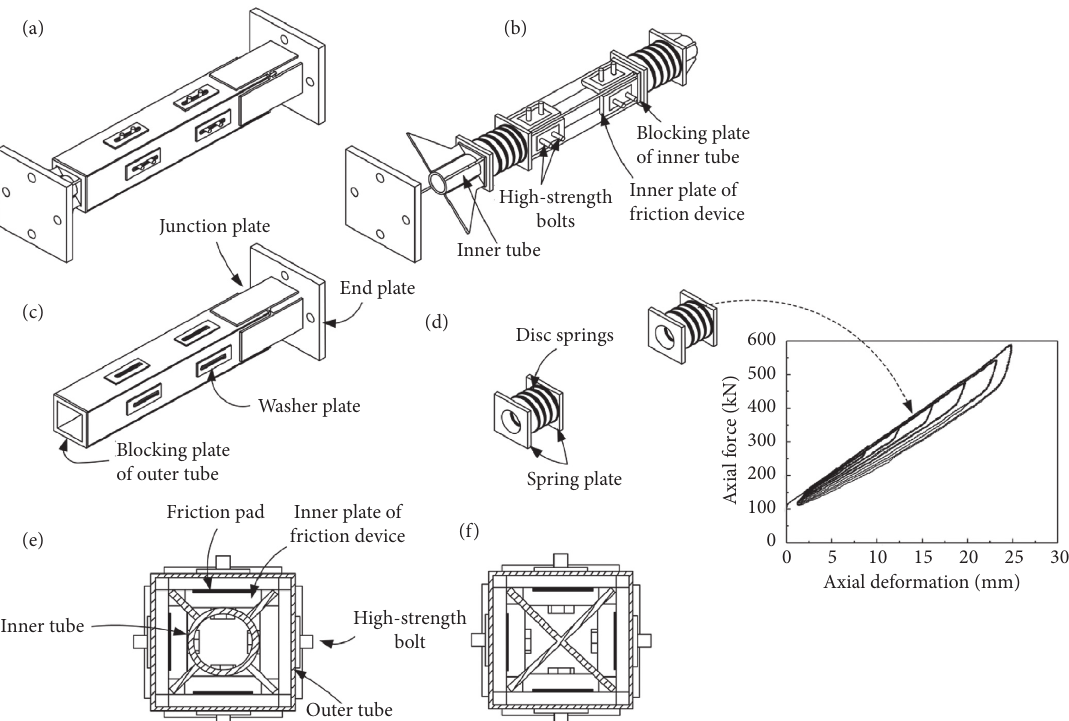
Figure 17: Schematic of PS-SCED bracing system: (a) PS-SCED brace assembly; (b) inner tube assembly; (c) outer tube assembly; (d) disc springs assembly and spring plates; (e) section A circular cross section of inner tube; (f) section A X-shaped cross section of inner tube (adapted from